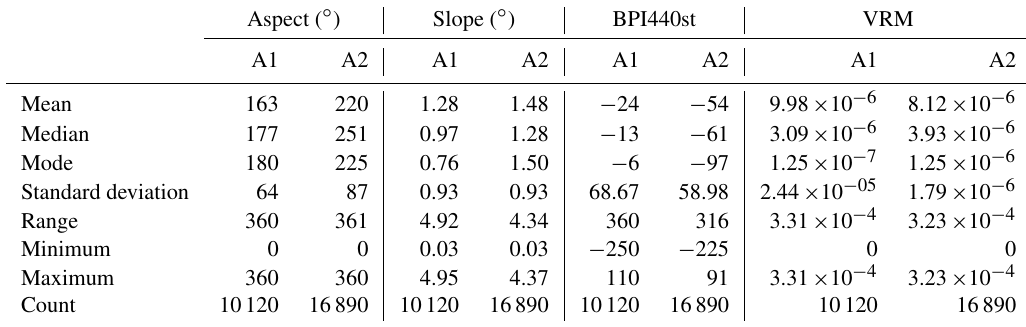
Table A6. Statistics summary of the derivatives derived from the AUV-obtained bathymetry for the A1 and A2 survey